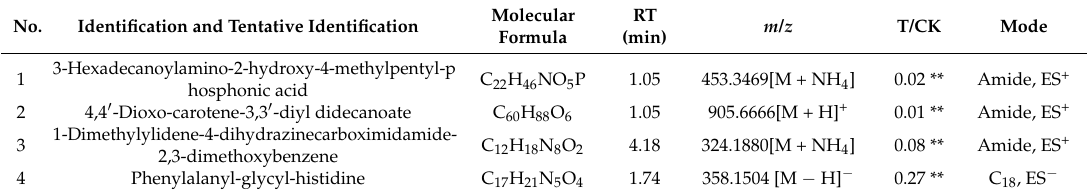
Table 4. Major secondary metabolites down-regulated by